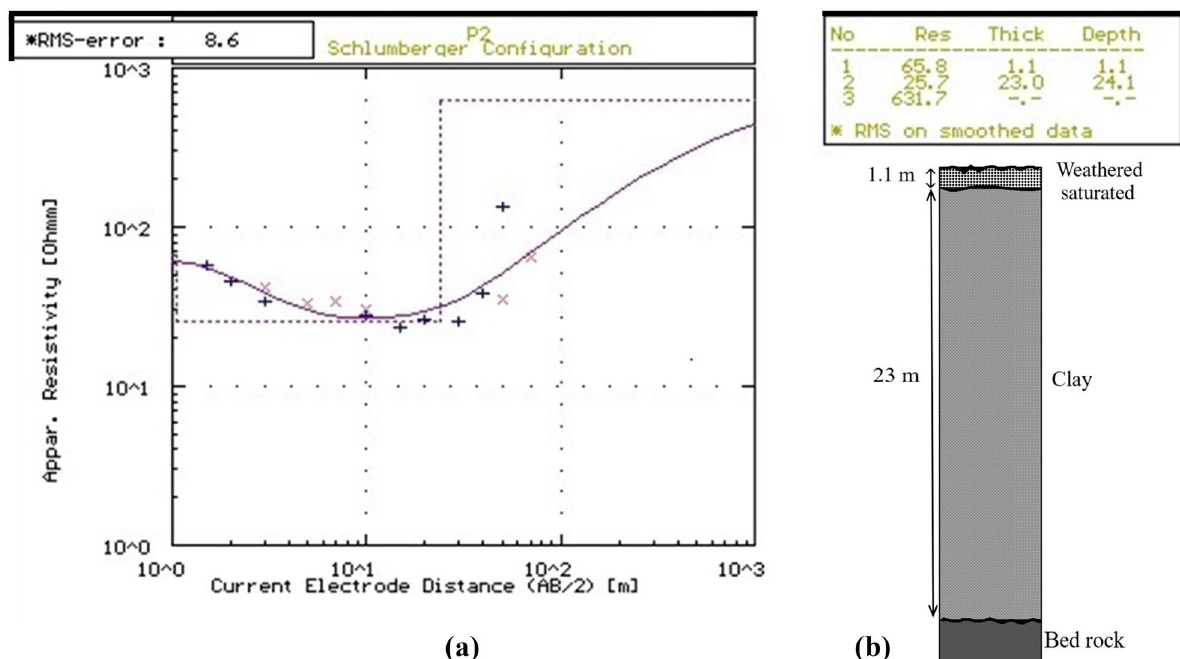
Fig. 5 a Curve matched from RESIST software for P2, b Geological profile for